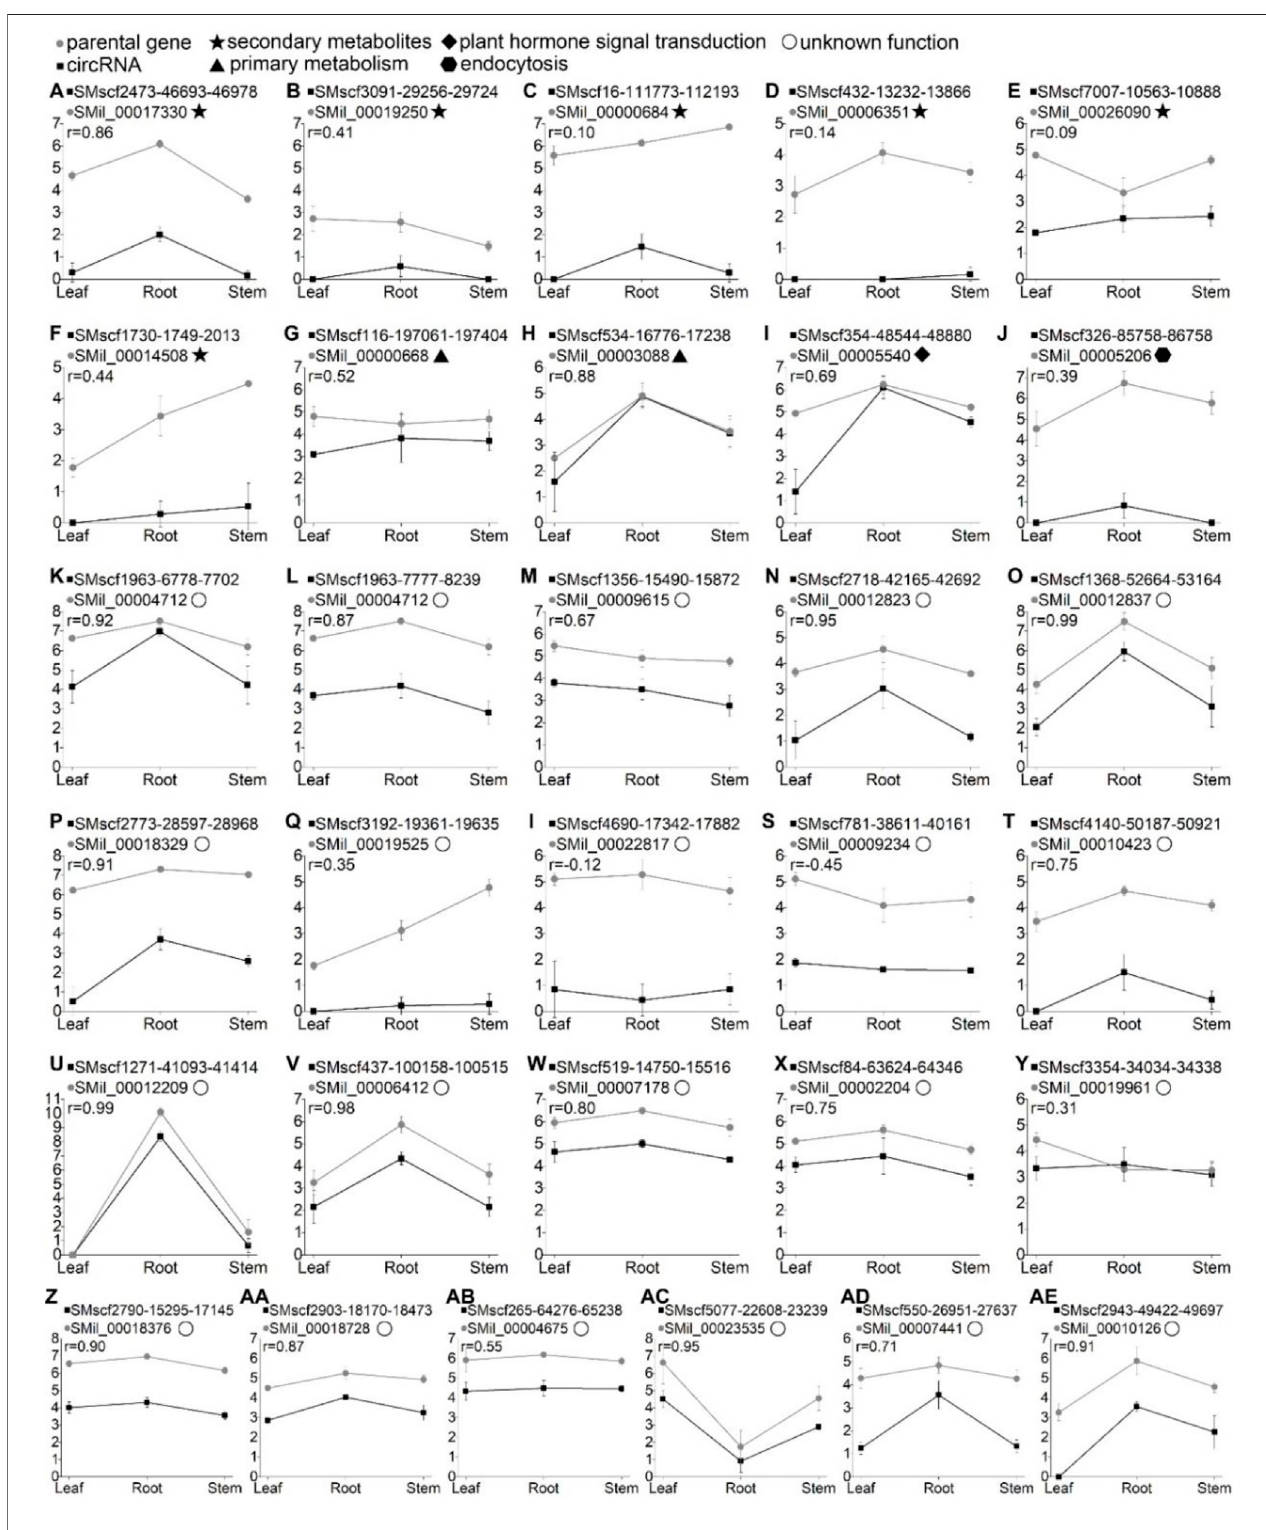
FIGURE 6 | The expression correlation of 31 validated circRNAs and their parental genes across the leaf, root, and stem tissues of S. miltiorrhiza . The X-axis shows the three tissues.Y-axisshowsexpressionlevelsofthecircRNAsinlog 2 (RPM)andtheparentalgenesinlog 2 (FPKM).Errorbarsrepresentthestandarderroramongthreereplicates. “ ” indicate thecircRNAname. “ ” indicatestheparentalgenename. “ r ” representsthecorrelationcoef fi cientofexpressionpro fi lesofthecircRNAsandtheirparentalgenes.Thedifferentsymbols aftertheparentalgenenamesrepresentthefunctionsofparentalgenesbasedontheKEGGpathwayanalyses. “ ” ,thepathwayofbiosynthesisofsecondarymetabolites; “ ” , thepathwayofprimarymetabolism; “ ” ,thepathwayofPlanthormonesignaltransduction; “ ” ,thepathwayofEndocytosis; “ ” ,thefunctionsofparentalgeneswereunknown.